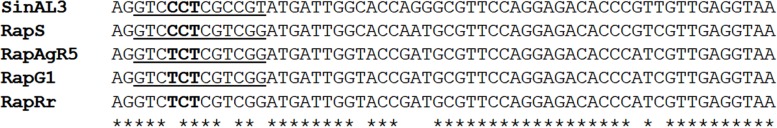
Sequence alignment of the CAD domain of the ALS gene in the four populations of R. rugosum (AGR5, G1, AGRr, and S) compared with a susceptible population of Sinapis alba (SINAL3). Proline by serine amino-acid substitution occurred in position 197. There are no amino acid changes in the C, D, B, and E domains of the R. rugosum ALS gene compared to S plants. Numbering of the ALS gene sequence alignment of Arabidopsis thaliana.